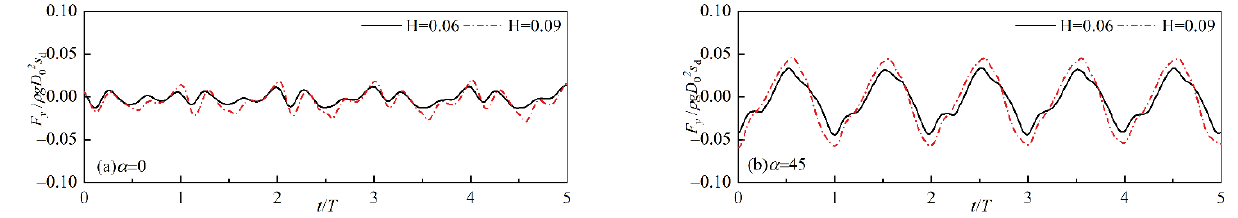
Figure 12. Time histories of transversal wave forces for wave cases of T = 0.9 s, H = 0.06 m and 0.09 m with incident direction of ( a ) α = 0° and ( b ) α = 45°.